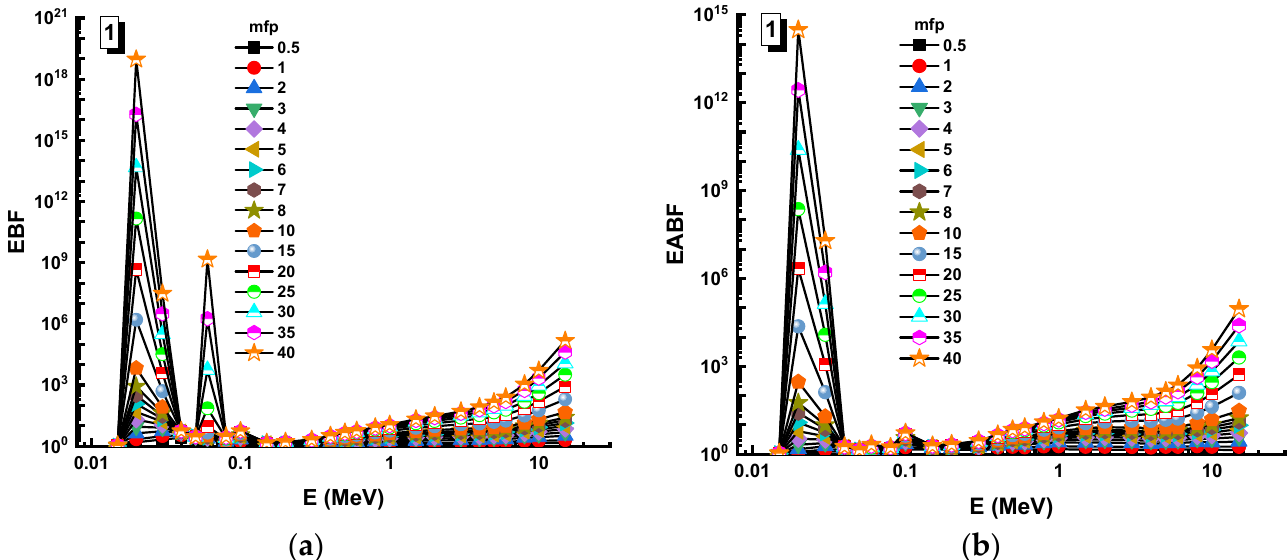
Figure 8. Variation of ( a ) EBF and ( b ) EABF against photon energy for Sample